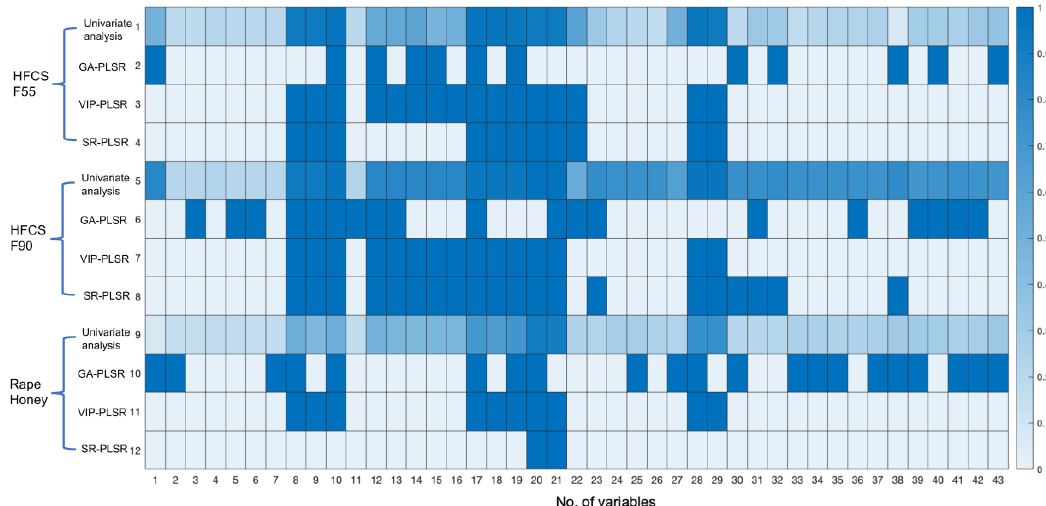
Figure 2. Feature variables selected with genetic algorithm (GA), variable importance in projection (VIP), and selectivity ratio (SR) methods. Row 1, 5, 9 shows the univariate analysis result between each variable and adulterant content of HFCS F55, HFCS F90, and rape honey, respectively. Cells with a gradient of blue color indicated the correlation coefficient. Other rows represented the variables selected by GA, VIP, and SR methods. Selected variables were represented in blue, and non-selected variables were in white.